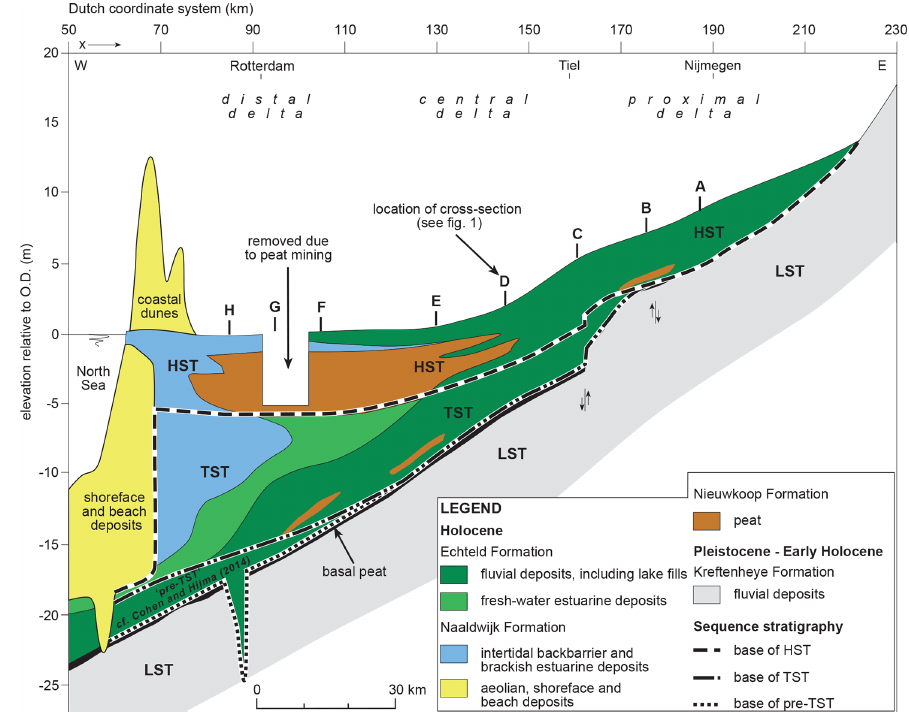
Figure 2. Schematic longitudinal section and sequence stratigraphy of the Holocene fluvio-deltaic wedge of the Rhine–Meuse delta (Hijma and Cohen, 2011 modified). Sequence stratigraphic classification is from Hijma and Cohen (2011) and Cohen and Hijma (2014). The wedge largely consists of a stacked succession of clastic fluvial deposits and organics (peat). Towards the coast, estuarine and intertidal sedimentary lobes form the larger part of the